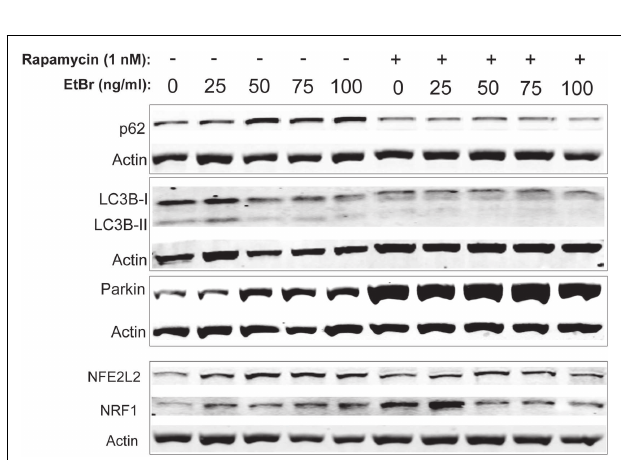
FIGURE 6 | Steady state levels of proteins involved in mitochondrial clearance and biogenesis following ethidium bromide exposure . Human fibroblast cell cultures grown in the presence or absence of 1nM rapamycin were exposed to increasing doses of ethidium bromide for a period of 7days. At this time, total cellular protein extracts were prepared and analyzed by immunoblot as described in Section “Materials and Methods” for a subset of mitochondrial resident proteins.The levels of beta-actin or beta tubulin are presented as a control for equal protein loading.The immunoblot presented is a representative blot of a minimum of two measurements with similar results.